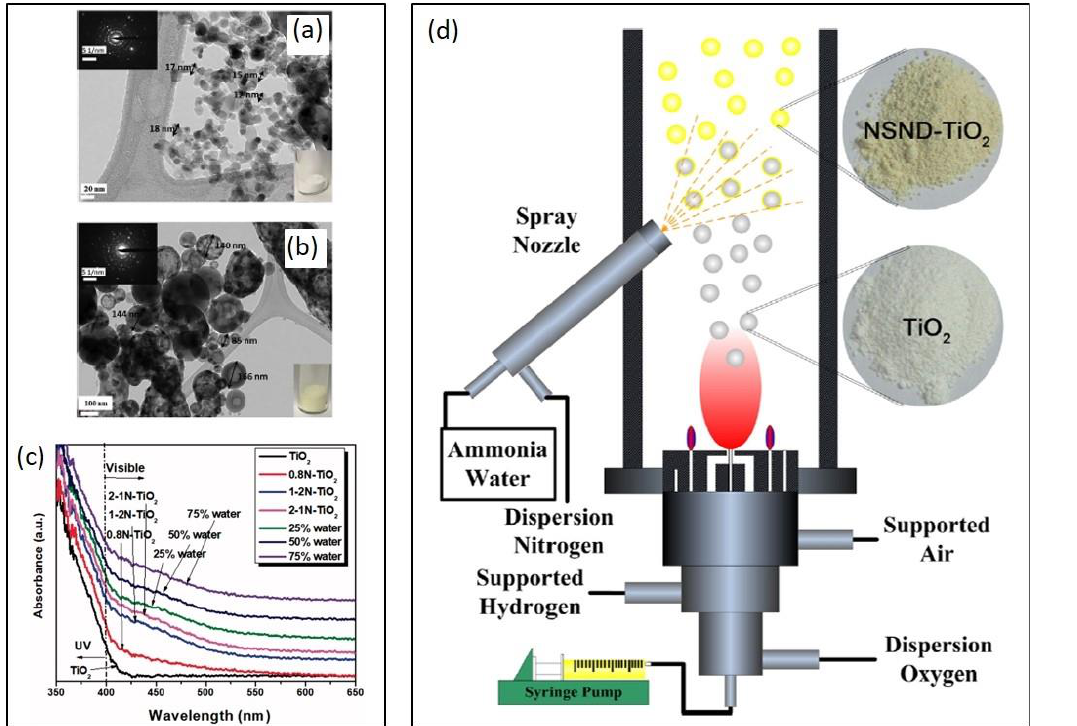
Figure 5. N-doped TiO 2 synthesized by mixing N-contained materials with Ti precursor and by supplying NH 3 solution into the flame chamber. TEM and digital camera images of TiO 2 : ( a ) pristine